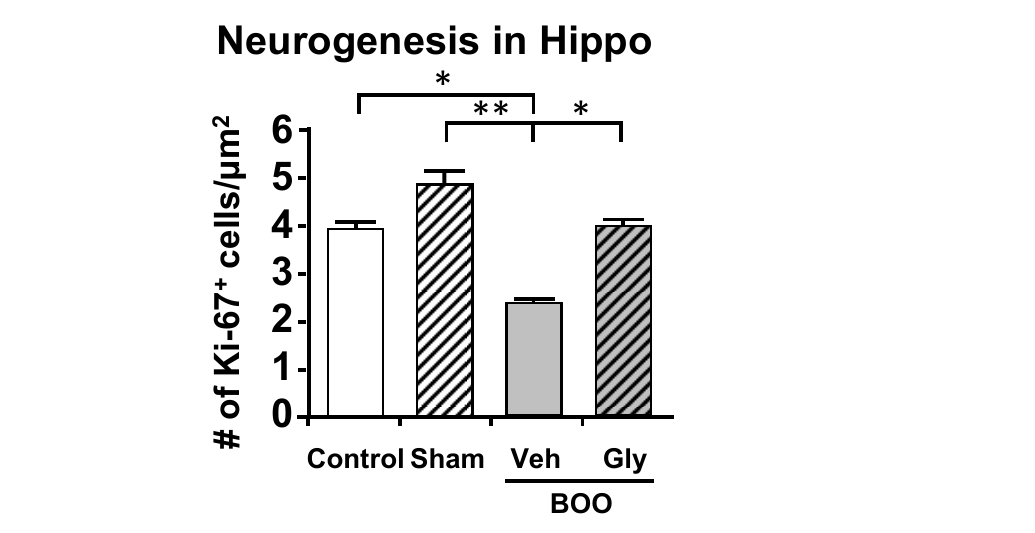
Figure 7. After 12 weeks of BOO the number of activated microglia in the hippocampus is increased and this increase was blocked by glyburide treatment. Activated microglia in 10 μ m sections of brain were stained for IbA1/AIF1 and then visualized and quantitated. The results are presented as the density of activated microglia per μ m 2 . Veh = vehicle ‐ treated, Gly = glyburide ‐ treated. Results are the mean ± 95% confidence intervals; ** p < 0.01 by ANOVA and Dunn’s test. ( n = 7, 6, 8, 7). This figured was reprinted, with permission from the Wiley Periodicals, from [9].